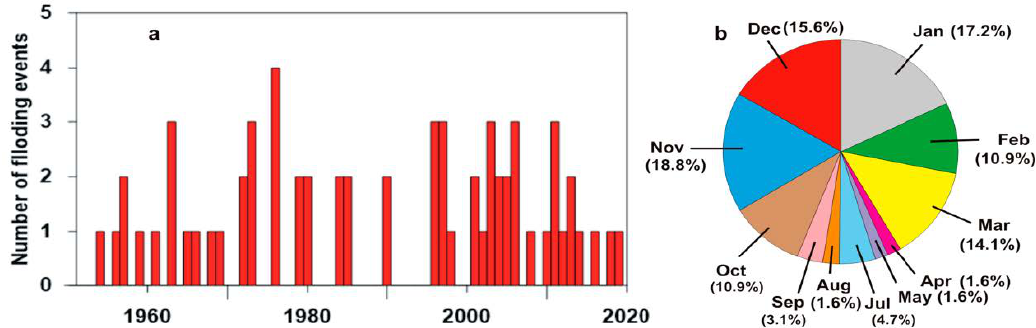
Figure 3. Annual frequency of flood events from 1951 to 2019 ( a ) and flood seasonality ( b ).